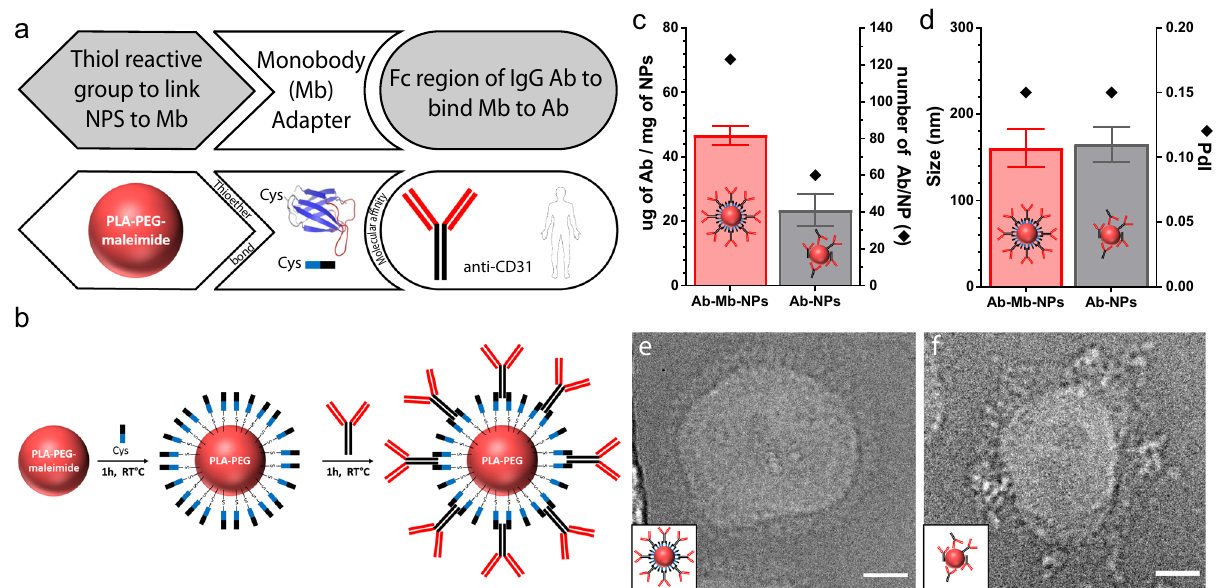
Fig. 1 | Fc-targeting monobody couples IgG antibody to the surface of nano- particles. a , b Schematics illustrating the conjugation of an antibody (Ab) to the surface of a nanoparticle (NP) using a Fc-targeting monobody as an adapter. c Graph of the mass of Ab per mg of NP calculated from the concentration in the conjugation supernatant determined by SDS-PAGE electrophoresis and number of Ab per nanoparticle calculated with a NP of 100nm in diameter and 1.25g/cm 3 in density (samples from n >10 distinct NP preparations). d Graph of the size